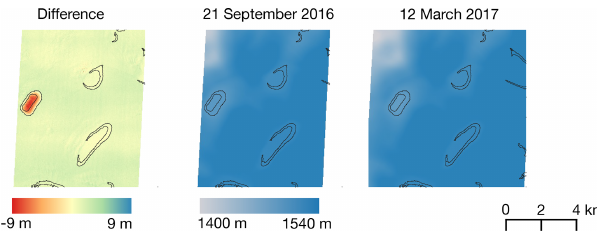
Figure 8. Elevation difference results of the ArcticDEM analysis to confirm the changes observed in the Sentinel-1 imagery and photo- clinometry